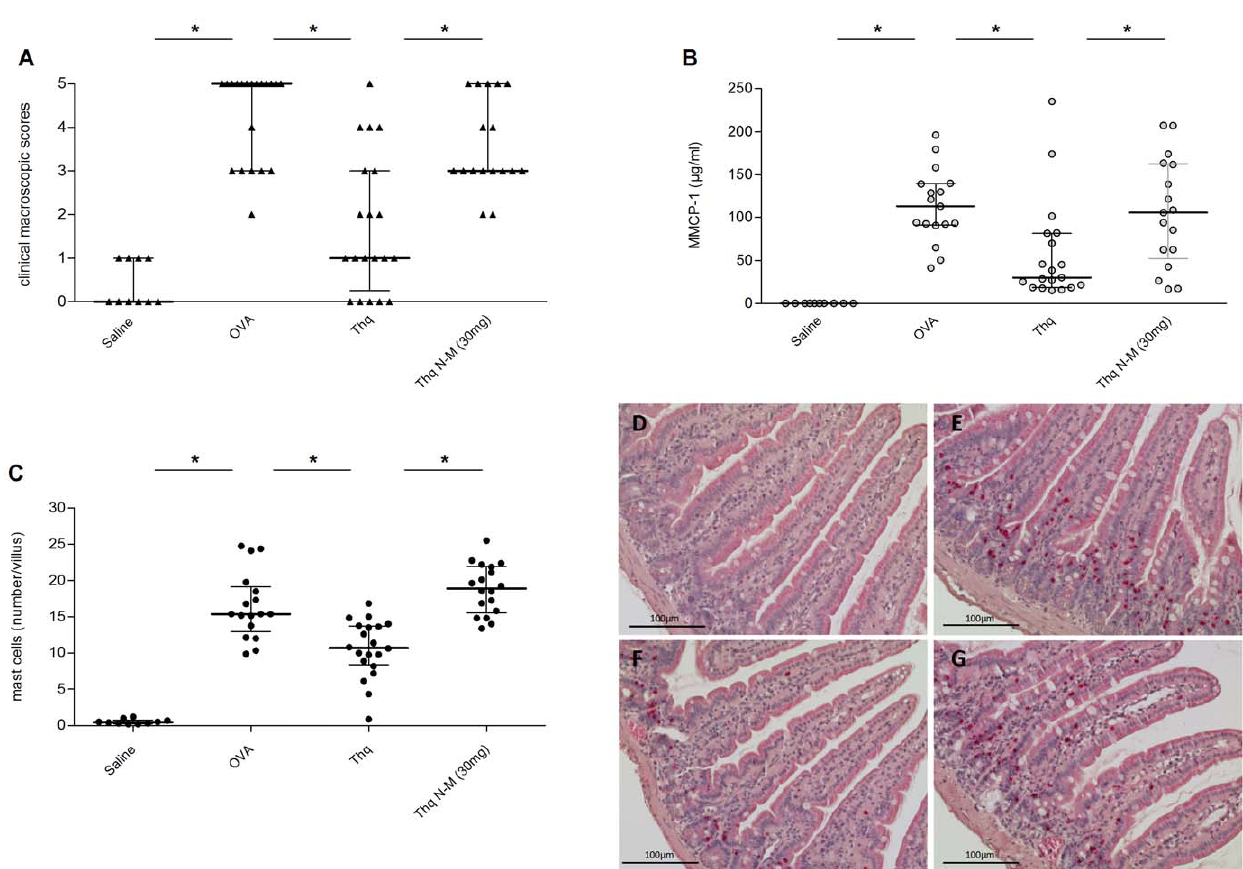
Figure 2. Thymoquinone decreases clinical symptoms, plasma MMCP-1 levels, and mast cell numbers in OVA-allergic mice. OVA- sensitized mice were challenged with saline (Saline), OVA (OVA), or with OVA after intragastric treatment with 13 mg/kgBW thymoquinone (Thq) and with thymoquinone after 30 mg/kgBW naloxone-methiodide pre-treatment (Thq N-M). Panel A represent the median of clinical macroscopic scores at sacrifice. Panel B shows the plasma concentrations of MMCP-1 and Panel C the numbers of mast cells per intestinal villus at sacrifice. The dots correspond to results from individual animals and the bars represent the median with interquartile range, *=p , 0.05, panels show the results from two pooled experiments, n=10–20. Panel D–G are representative histological pictures of mast cells in the jejunum of OVA-sensitized mice challenged with saline ( D ), OVA ( E ), or with OVA after intragastric treatment with 13 mg/kgBW thymoquinone ( F ) and with thymoquinone after 30 mg/kgBW naloxone-methiodide pre-treatment ( G ). Mast cells appear in bright red.